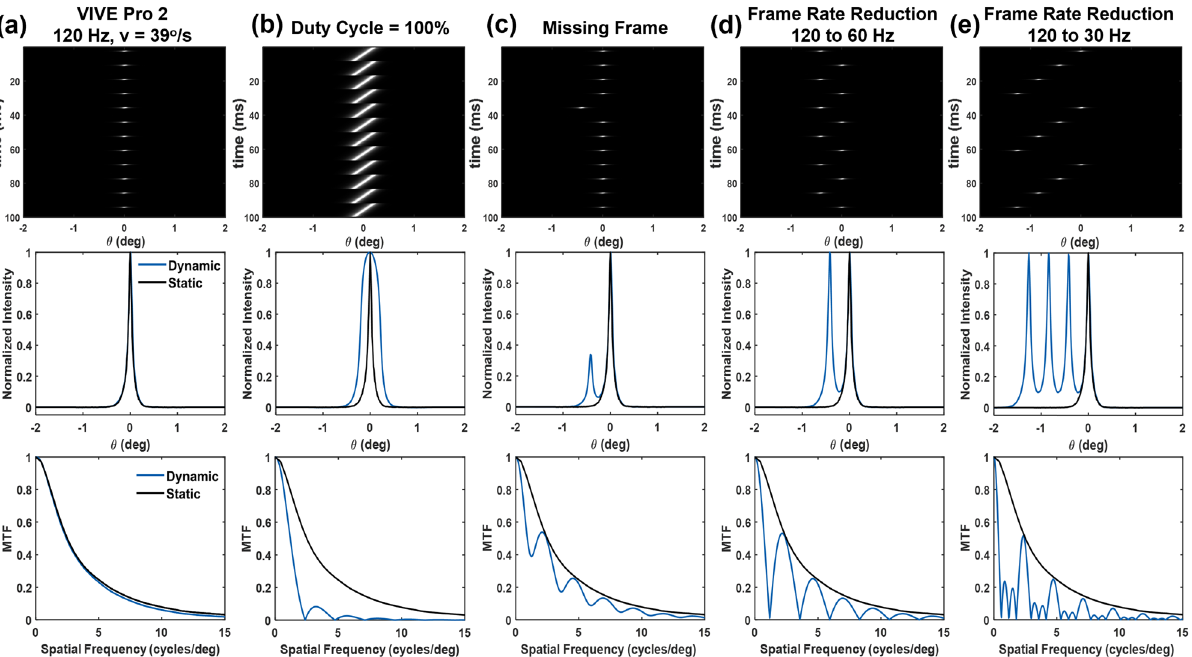
Figure 10. Spatiotemporal illustrations (first row), static and dynamic LSFs (second row) and MTFs (third row) of a moving line at 39°/s motion speed on the VIVE Pro 2 with 120 Hz refresh rate ( a ). Illustrations of motion image artifacts of the line by ( b ) a continuous emission with 100% duty cycle, ( c ) missing a single frame update, and frame rate reduction from 120 Hz to ( d ) 60 Hz and ( e ) 30